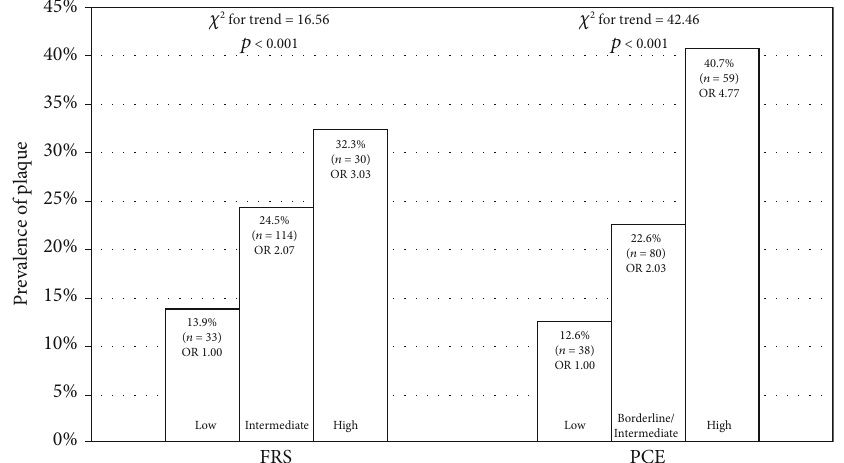
Figure 1: Association between plaque prevalence and ASCVD risk strati fi cation (FRS and PCE). There was a signi fi cant linear trend among the ordered categories de fi ning the 10-year ASCVD risk (FRS and PCE) and the prevalence of plaques. ASCVD: atherosclerotic cardiovascular disease; FRS: Framingham risk score; PCE: pooled cohort equation; OR: odds